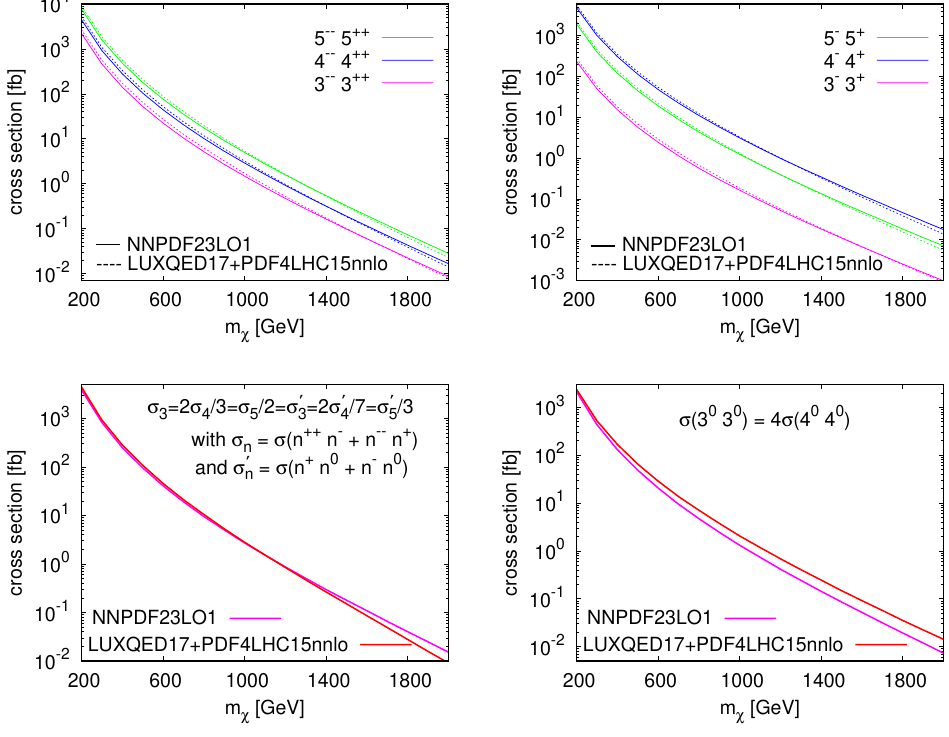
Figure 4 . Cross sections for Drell-Yan pair (top and bottom right panel) and associated (bottom left panel) productions of exotic fermions at 13 TeV